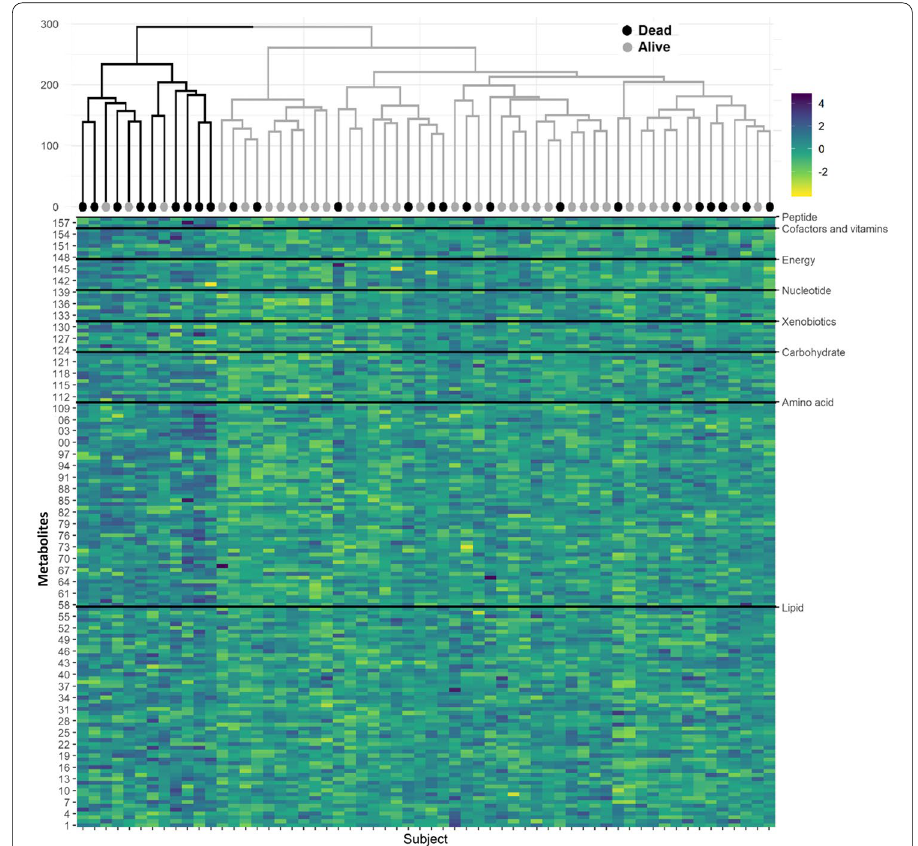
Fig. 1 Heatmap showing normalized metabolite levels grouped by super‑pathway among patients with sepsis. Heatmap showing normalized metabolite levels (rows), grouped by super‑pathway, among patients with sepsis following hierarchical clustering (dendrogram, top); survival status is annotated (grey black no). Differences in the metabolome among survivors and non‑survivors were noted across multiple = metabolic